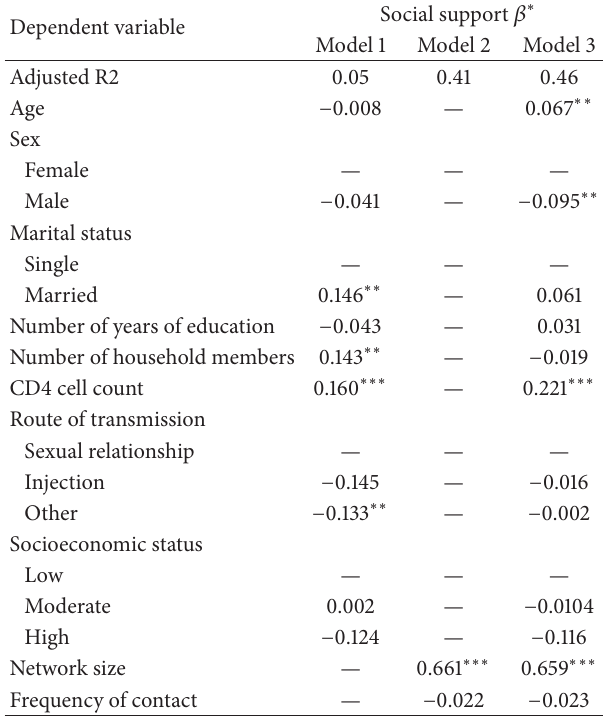
Table 4: Frequency of contact of participants in study.